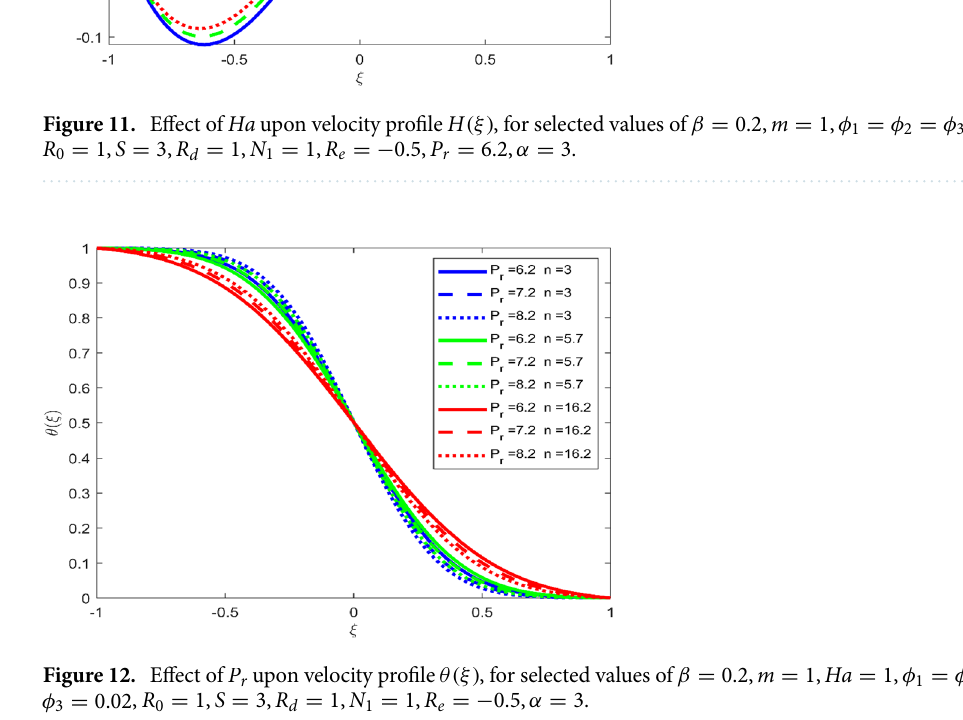
Figure 12. Effect of P r upon velocity profile θ(ξ) , for selected values of β = 0.2, m = 1, Ha = 1, φ 1 = φ 2 =